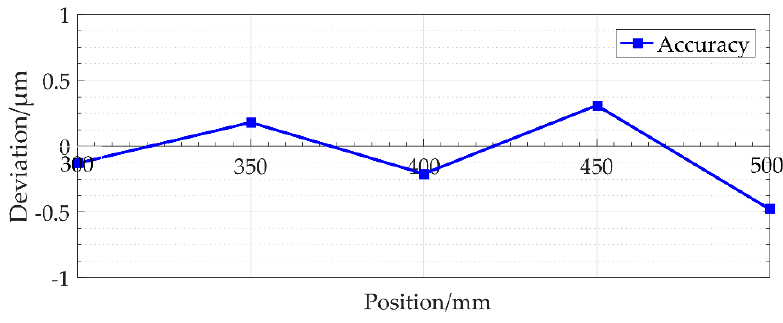
Figure 13. Grating lithography accuracy detection at 200-mm-length.